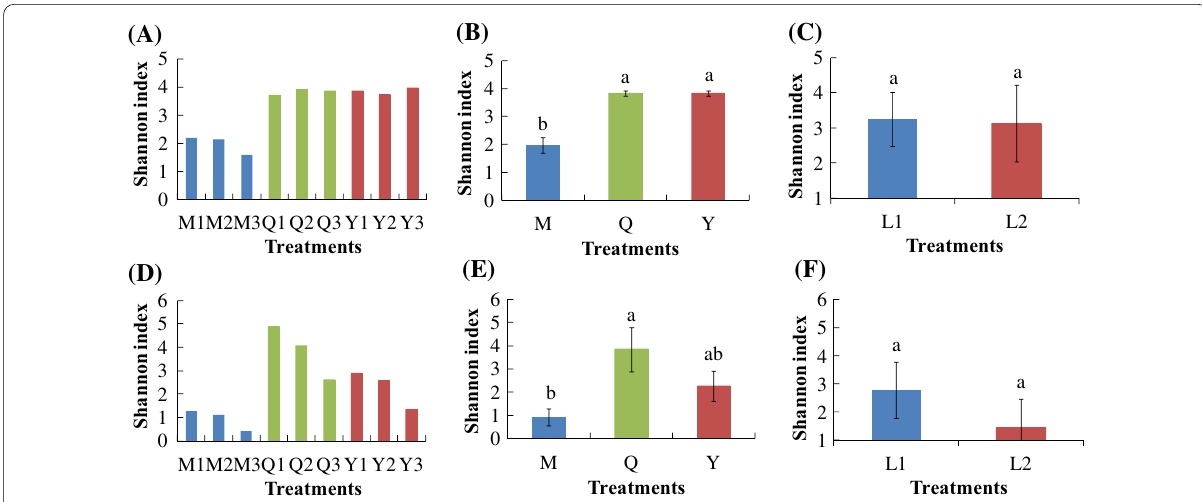
Fig. 2 Effect of treatments ( A / D ), microflora source ( B / E ), and liquid volume ( C / F ) on bacterial ( A / B / C ) and fungal ( D / E / F ) α-diversity. M, microbial consortia source from MC1; Q, microbial consortia source from MC1, sheep, and cattle feces; Y, microbial consortia source from sheep feces; L1, 100 mL PCS medium; L2, 200 mL PCS medium. Values followed by different letters are significantly different at P < 0.05